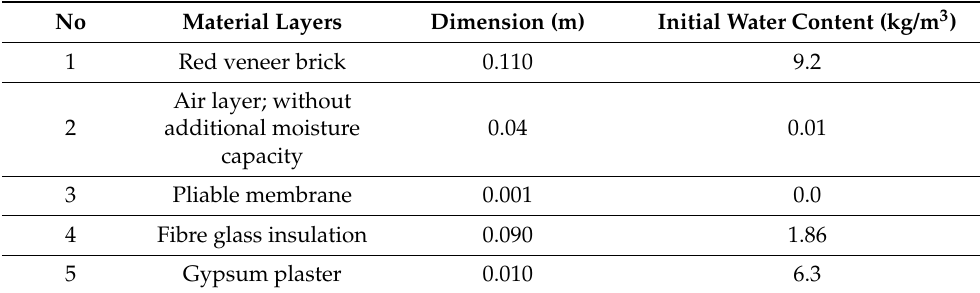
Table 4. Initial moisture content in each layer of the wall